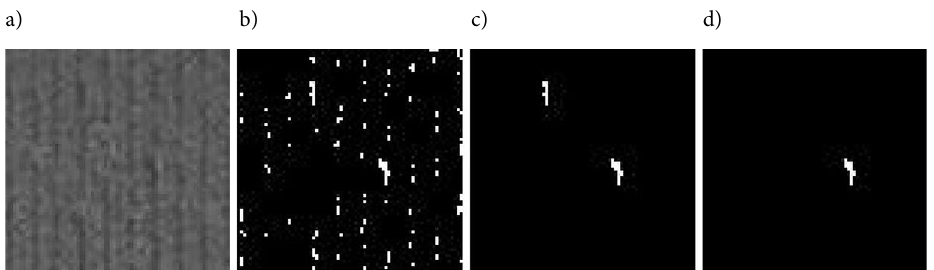
Figure 8. Example of non-crack pavement block with light longitudinal tined texture (from left to right): a – raw crack block; b – local filtering; c – minor removal; d – maximum